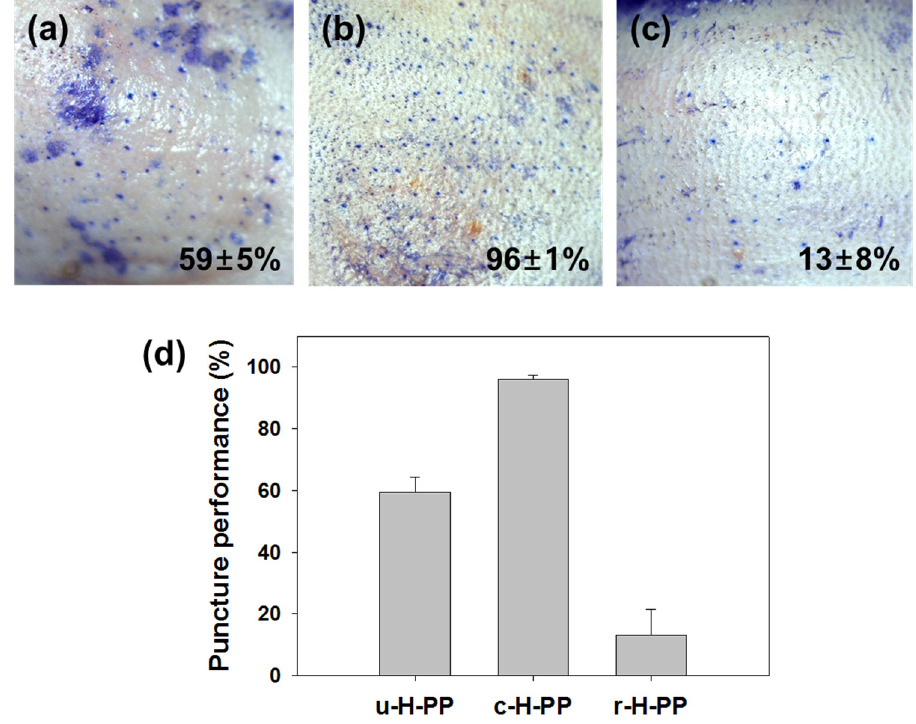
Figure 4. Image of in vivo mouse skin stained with trypan blue after insertion and removal of ( a ) u-H-PP-MNs (uncoated microneedles with high aspect ratio), ( b ) c-H-PP-MNs (coated microneedles with high aspect ratio) and ( c ) r-H-PP-MNs (microneedles with coated formulation removed with high aspect ratio); ( d ) in vivo puncture performance comparison of u-H-PP, c-H-PP and r-H-PP.